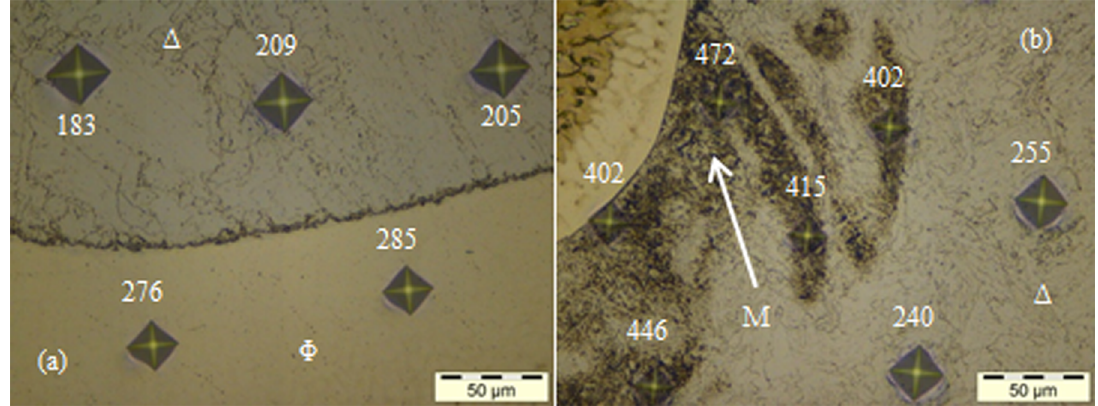
Figure 13. MO with microindentations in the PMZs. (a) zones Φ and Δ. (b) zones Δ, M, Φ and